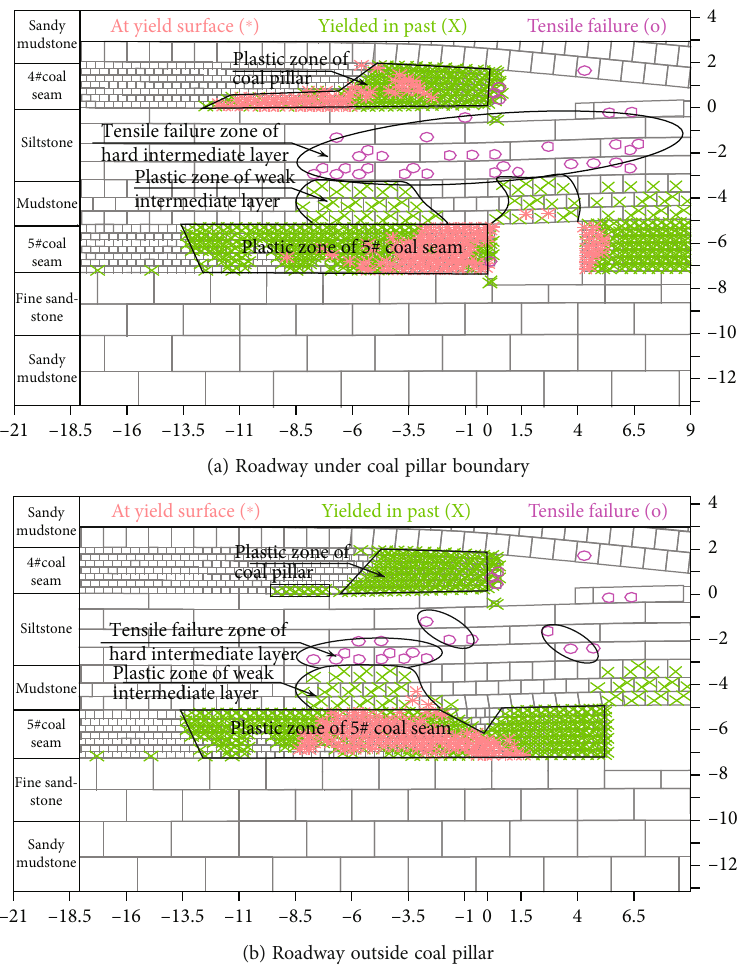
Figure 12: Failure distribution of strata with di ff erent roadway